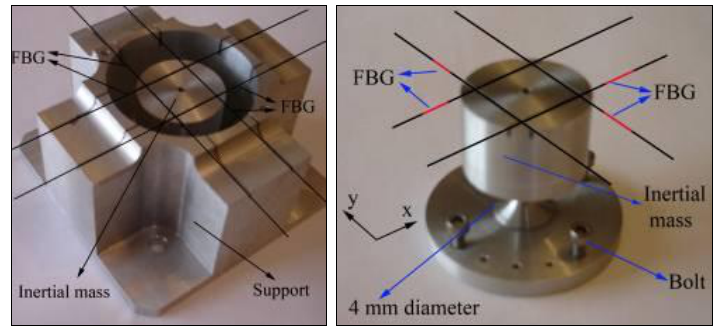
Figure 1. Design of the implemented accelerometer ( left ) and schematic of the central aluminum piece of the implemented accelerometer ( right